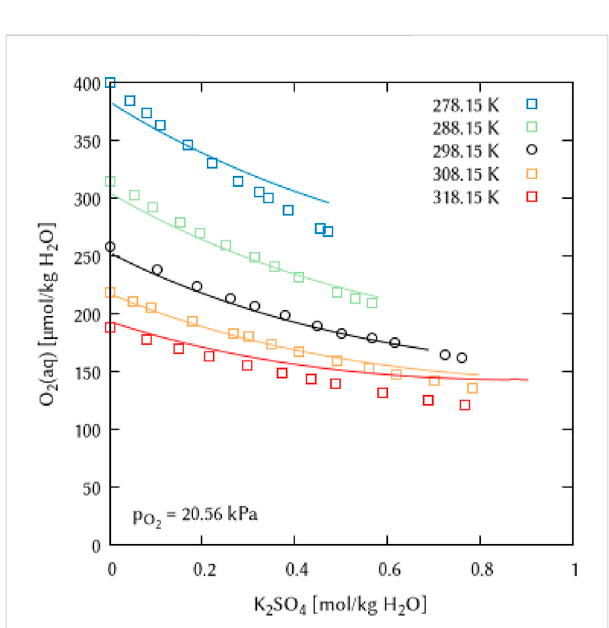
FIGURE 17 Modelling of the O 2 solubility in potassium sulfate solution as a function of temperature and K 2 SO 4 concentration. (Points: Experimentaldatafrom ○ Milleroetal.(2003)and □ MilleroandHuang (2003), Lines: this work).